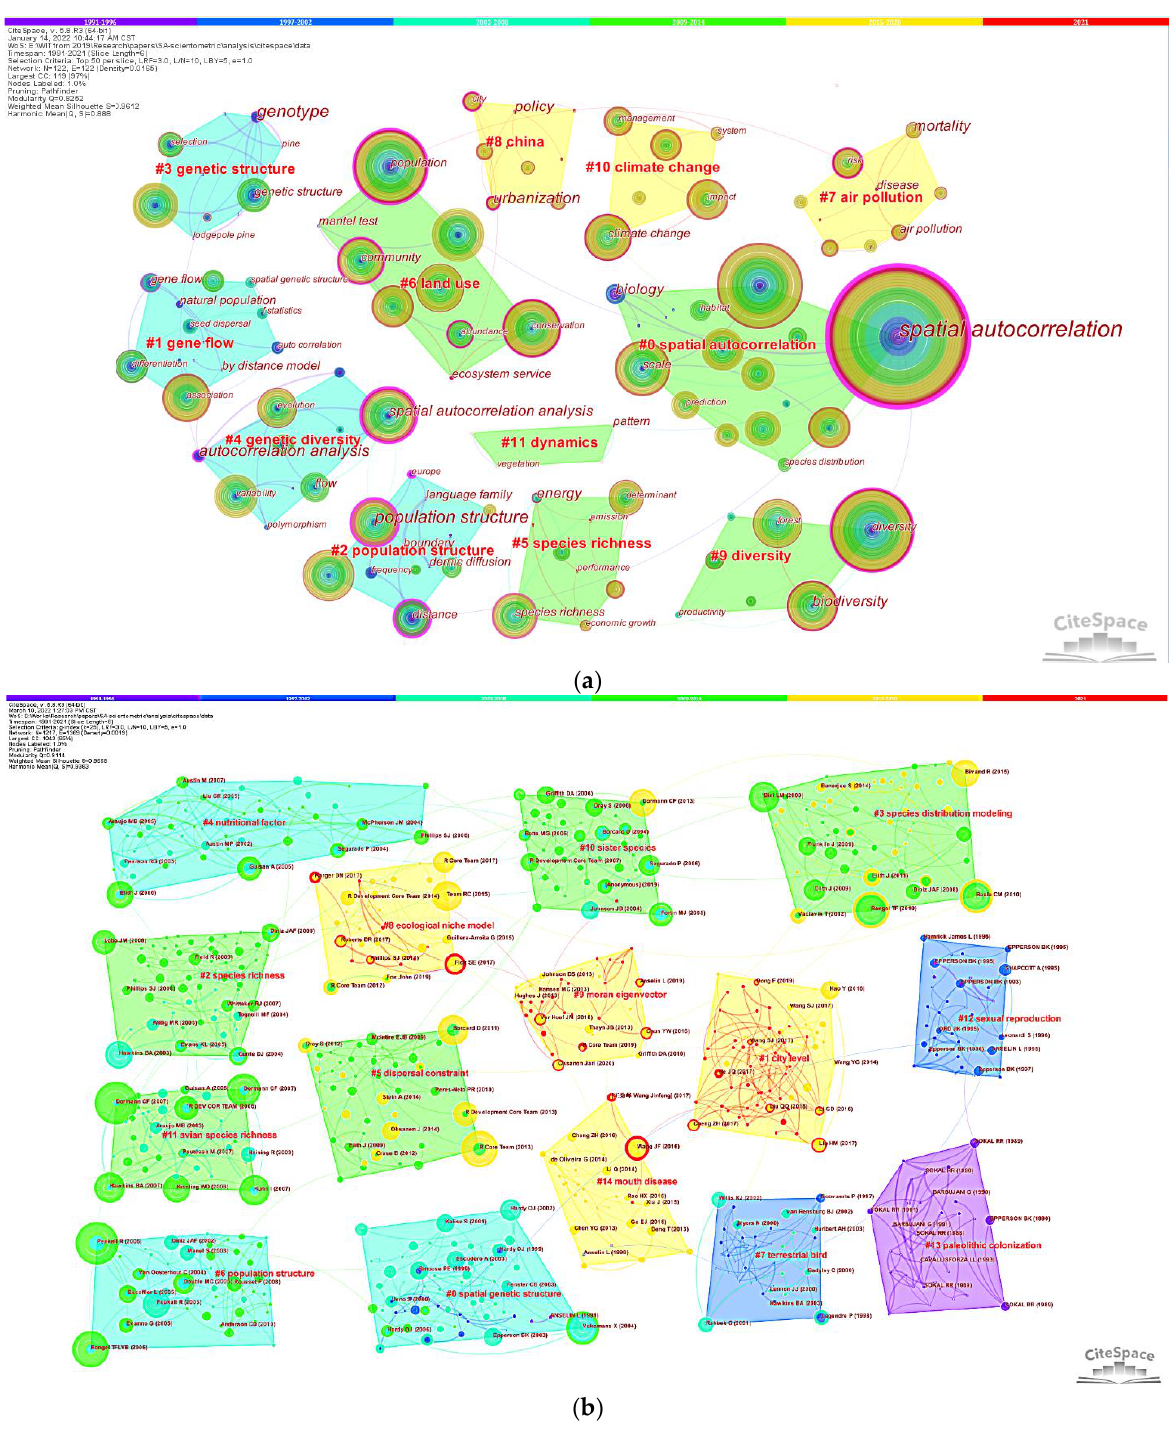
Figure 10. Co-keyword and co-citation clusters. ( a ) co-keyword clusters and ( b ) co-citation clusters. (Representation of the timeline: 1991–1996 (the purple strip), 1997–2002 (the blue strip), 2003–2008 (the cyan strip), 2009–2014 (the light-green strip), 2015–2020 (the yellow strip), and 2021 (the red strip).) Convex hulls of different time periods are, respectively, colored; e.g., in the co-keyword clusters map, there are three clusters in 2015–2020, and in the co-citation clusters map, there are four clusters. A keyword’s color(s) is/are coincidence with its year(s) color(s), e.g., “spa- tial autocorrelation “ is colored purple, blue, cyan, light-green, yellow, and red like annual rings,